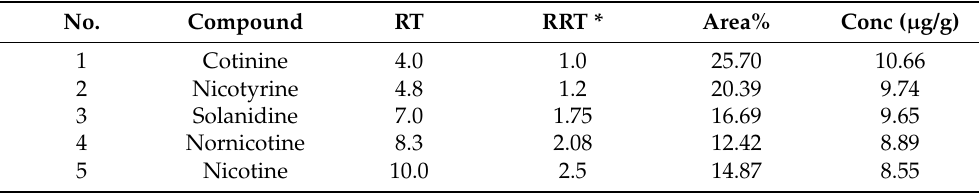
Figure 4. HPLC chromatogram of C. diurnum leaf parts (ethanolic extract). Table 2. Alkaloid components of C. diurnum L. leaves extract identified by